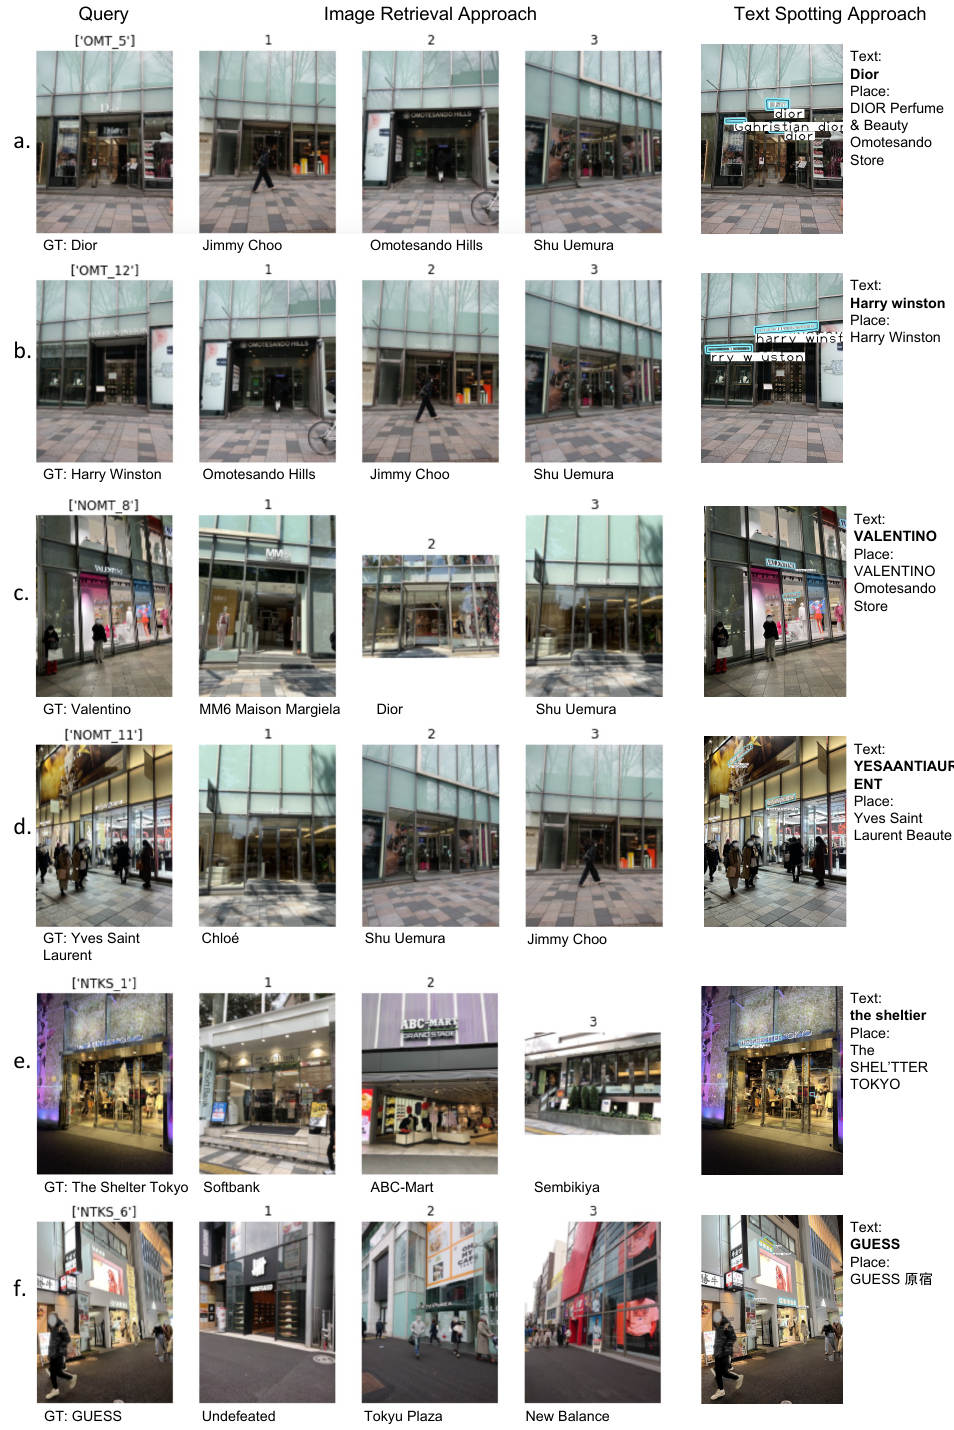
Figure 8. Image retrieval approach vs. VPRText. Examples where VPRText performs better compared to image retrieval in challenging conditions: ( a , b )—perceptually aliased—day, ( c , d )—Perceptually aliased—night, and ( e , f )—general night/illuminated. First column shows the query image, followed by the top 3 image retrieval results, and the last column shows the VPRText